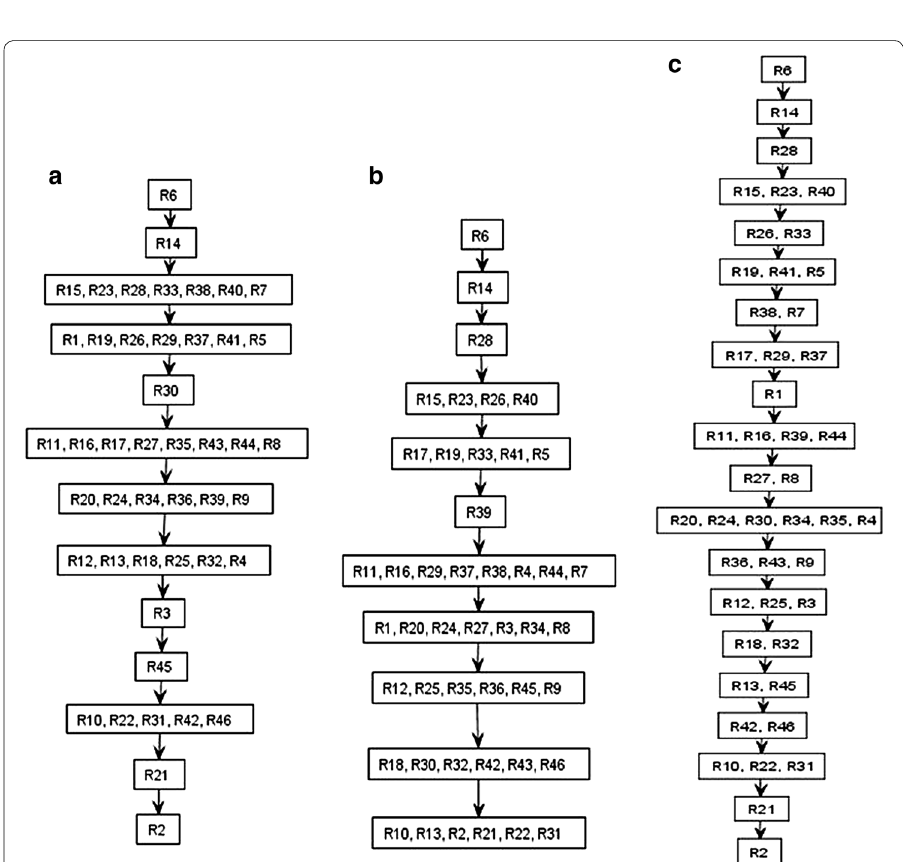
Fig. 5 a Descendant ranking, b ascendant ranking, c median